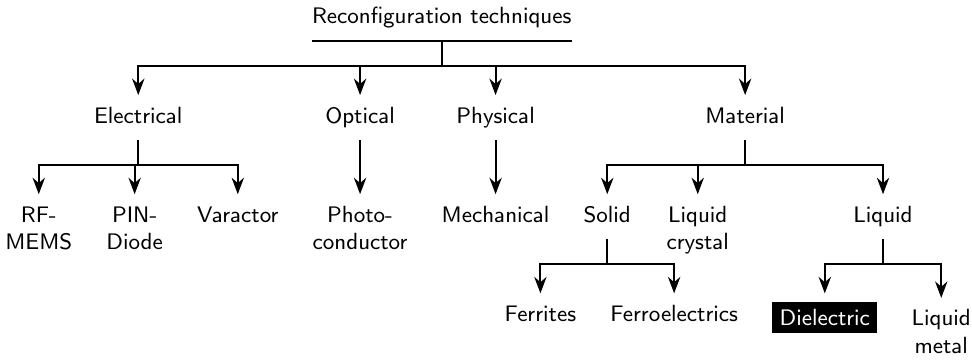
Figure 1. Categorization of antenna reconfiguration